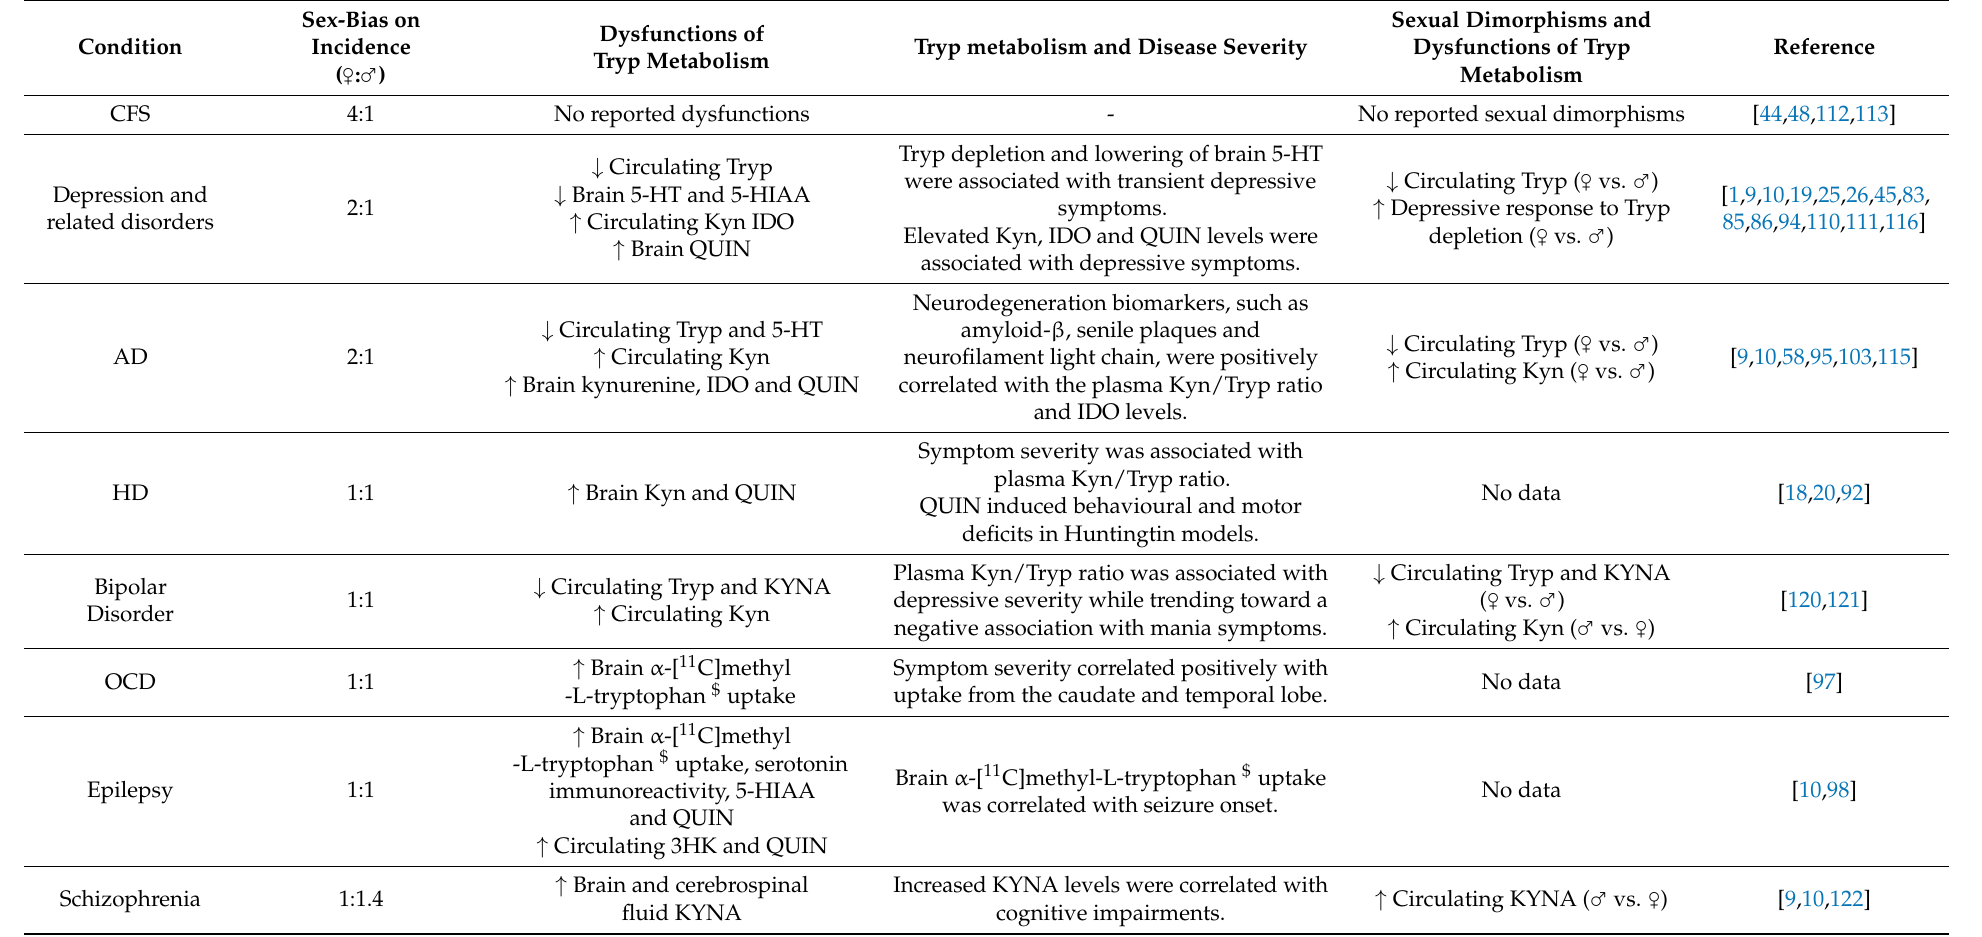
Table 6. Summary of the reported dysfunctions of tryptophan metabolism, its relation to disease severity, and described sexual dimorphisms for some neuropsychi- atric